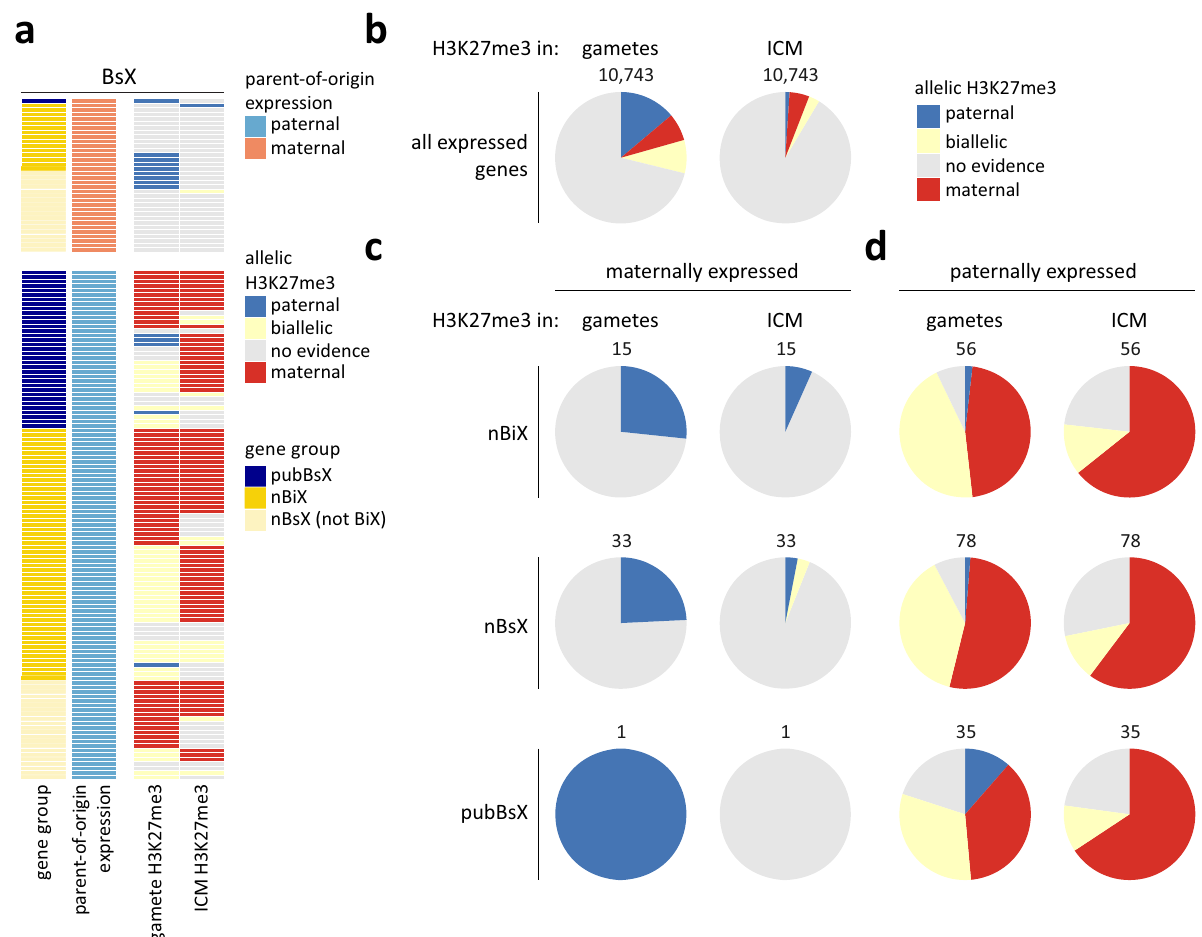
Fig. 4 Correlation of gamete-speci fi c H3K27me3 with parental-allele-speci fi c gene expression. a Heatmap showing associations between BsX genes and ICM-allele-speci fi c or gamete-speci fi c H3K27me3. Colour codes distinguish between allelic expression of BsX genes (maternal or paternal), allelic presence of H3K27me3 (on paternal or maternal alleles in the ICM, or in sperm and/or oocyte), and different gene groups (pubBsX, nBiX or nBsX genes). b Pie charts illustrating the occurrence of ICM allele-speci fi c or gamete-speci fi c H3K27me3 at the TSS of all 10,743 robustly detected transcripts. c , d Pie charts illustrating the occurrence of allele- (in the ICM) or gamete-speci fi c H3K27me3 at the TSS of maternally ( c ) or paternally ( d ) expressed nBiX, nBsX and pubBsX genes. Source data are provided as Source Data fi